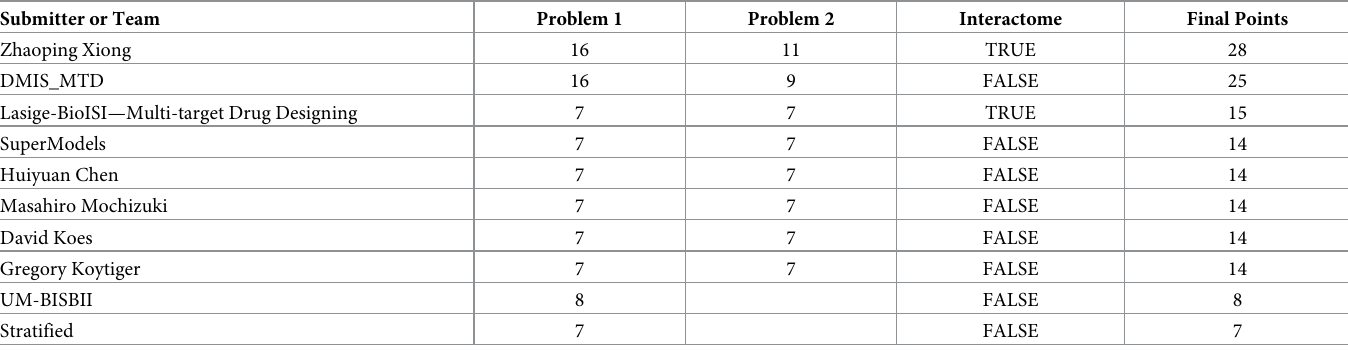
methods utilized multiple steps including (i) combining structure- and ligand-based approaches, (ii) applying one or more machine learning/classification algorithms, (iii) use of other computational approaches such as filtering, ligand docking, or creation and application of confidence scoring metrics to identify compounds for the two problems, or (iv) manual selection of the top candidates. Importantly, some teams used fully automated methods, while others used approaches that required several manual curation steps. While the majority of Table 2. Challenge scoreboard. “Submitter or Team” indicates which team was scored. The “Problem 1” and “Problem 2” scores indicate each team’s performance in the two problems as scored using the criteria described in Table 1. “Interactome” indicates whether the team participated in a text-mining exercise to facilitate team interaction for bonus points. “Final Points” indicates the final score for each team. Submitter or